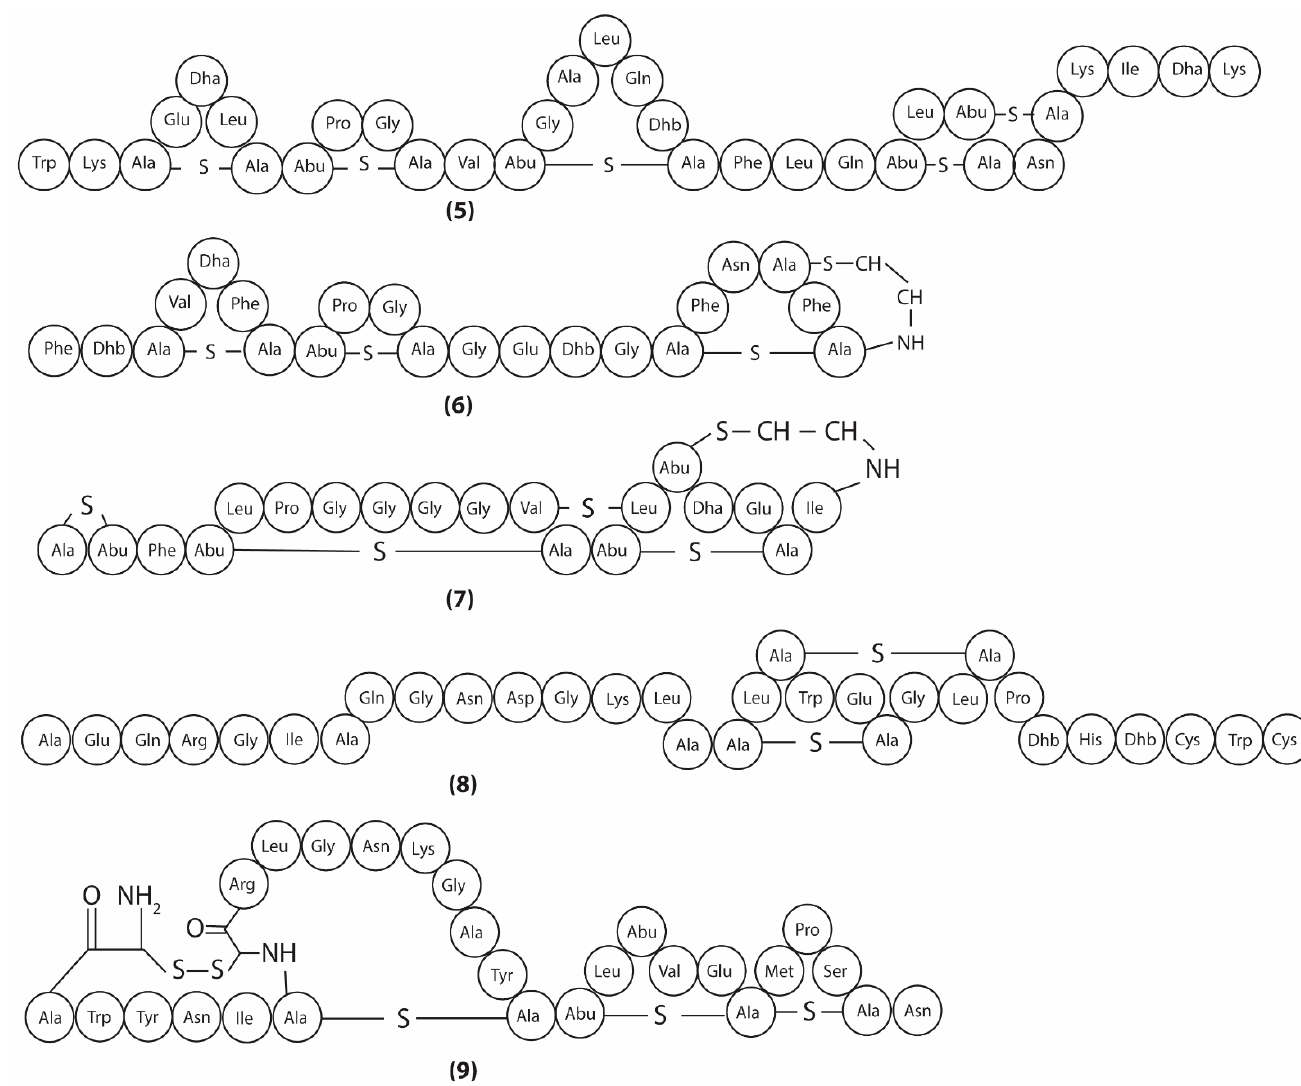
Figure 4. Chemical structures of subtilin ( 5 ), clausin ( 6 ), mersacidin ( 7 ), amylolysin A ( 8 ), and haloduracin ( 9 ).